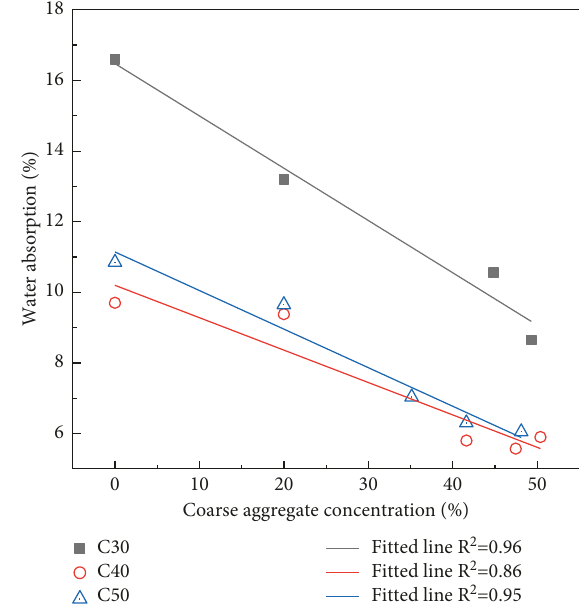
Figure 11: Relationship between volumetric water absorption and coarse aggregate